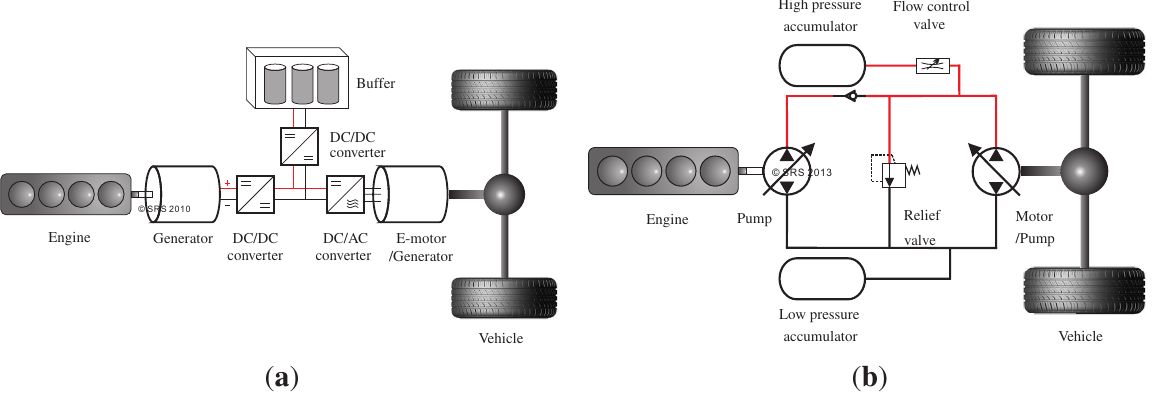
Figure 2. Series topology of ( a ) hybrid electric vehicle; ( b ) hybrid hydraulic